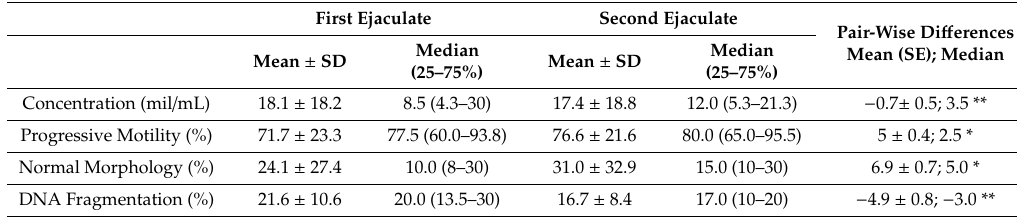
Table 4. Conventional sperm parameters and DNA fragmentation of two consecutive ejaculates of patients with oligo, astheno- and / or terato-zoospermia separated by swim-up ( n =